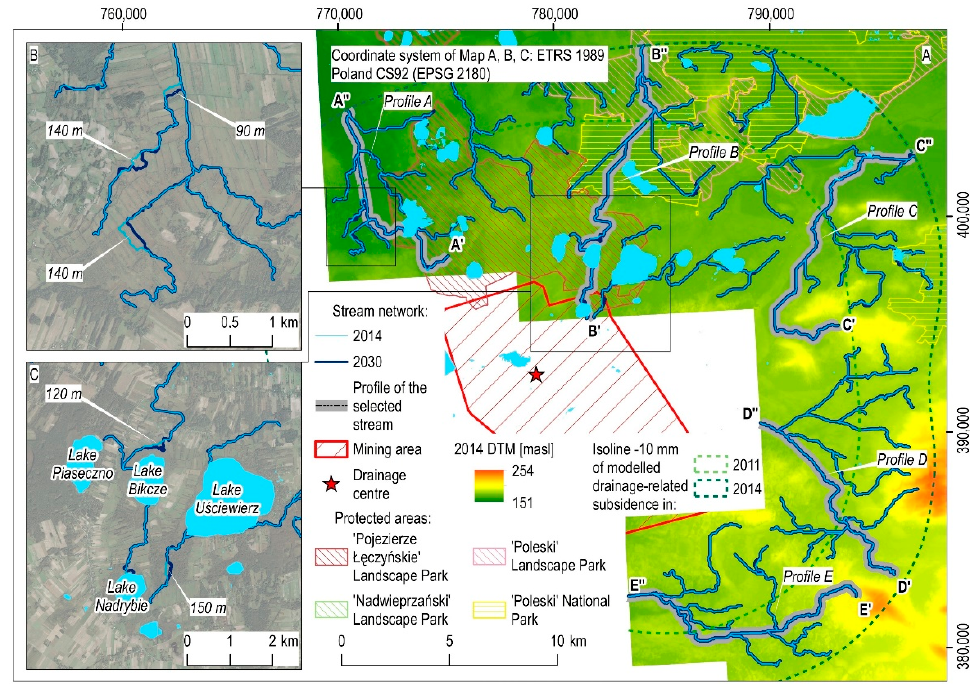
Figure 12. ( A ) The spatial distribution of the stream network determined based on hydrological analyses performed using 2014 and 2030 DTMs, protected areas, and the location of the main lakes in the area of interest. The changes in the spatial distribution of the stream network marked by white arrows and determined in [m] in the vicinity of ( B ) Lake Nadrybie and Bikcze and ( C ) Lake Krzecze-Krasne between 2014 and 2030.